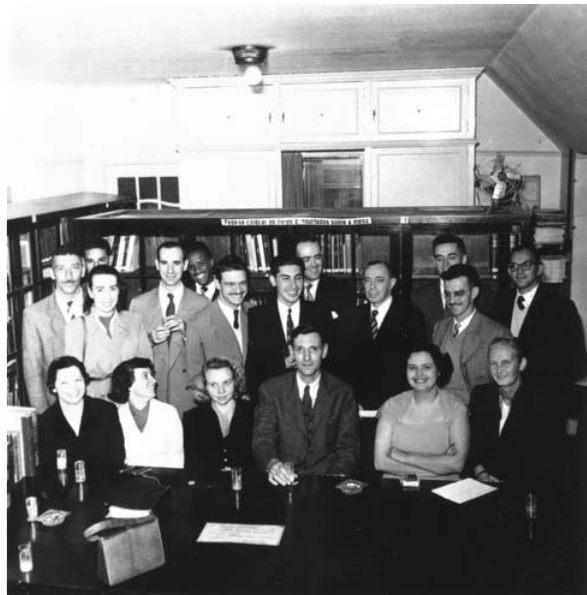
Figure 1 - Marta Erps Breuer in 1937 with her microscope, most probably at Dreyfus’ lab in the Departamento de Biologia Geral , then on the third floor of the Faculdade de Medicina building (415 Dr. Arnaldo avenue), São Paulo city (SP), Brazil (M. Grellet phot .).